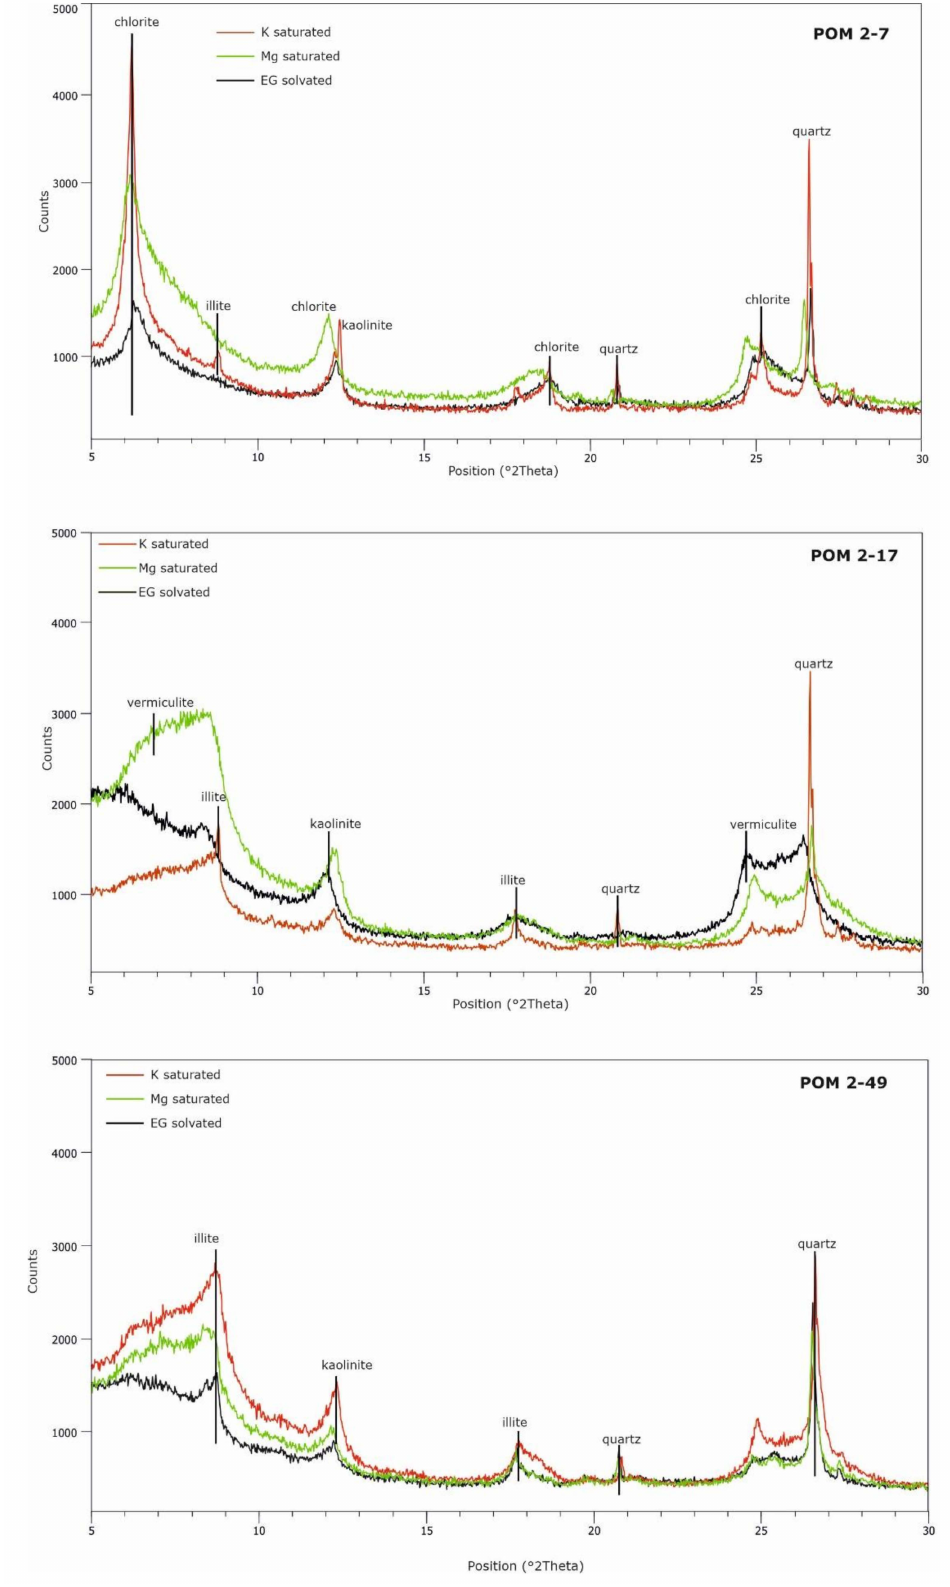
Figure 7. X-ray diffraction patterns of three selected sediment samples: POM 2-7, POM 2-17, and POM